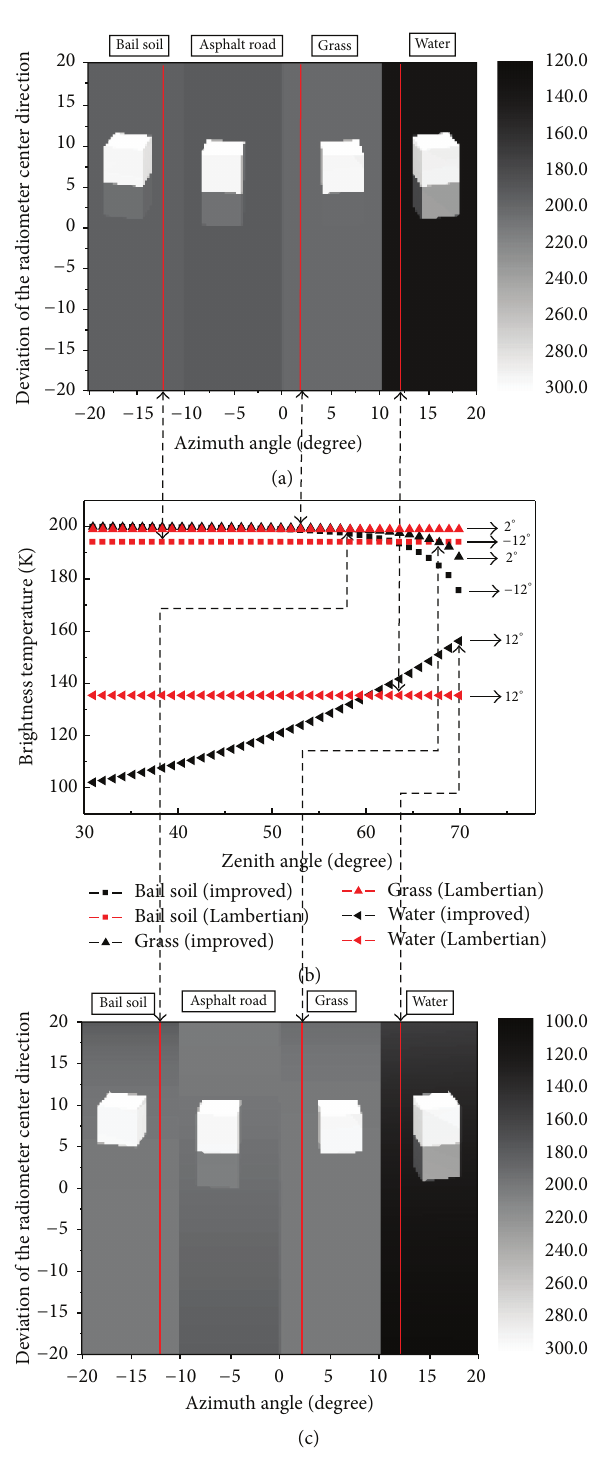
Figure 14: (a) Simulated image of Lambertian model. (b) Comparison between improved models with the Lambertian model. (c) Simulated image of improved model. In (a) and (c) the parameters of the four rough surfaces from left to right are, respectively, ( 𝜎 = 0.0003 m, 𝐿 = 1.6 𝜆 ), ( 𝜎 = 0.15m, 𝐿 = 10 𝜆 ), ( 𝜎 = 0.0001 m, 𝐿 = 1.6 𝜆 ), and ( 𝜎 = 0.1m, 𝐿 = 10 𝜆